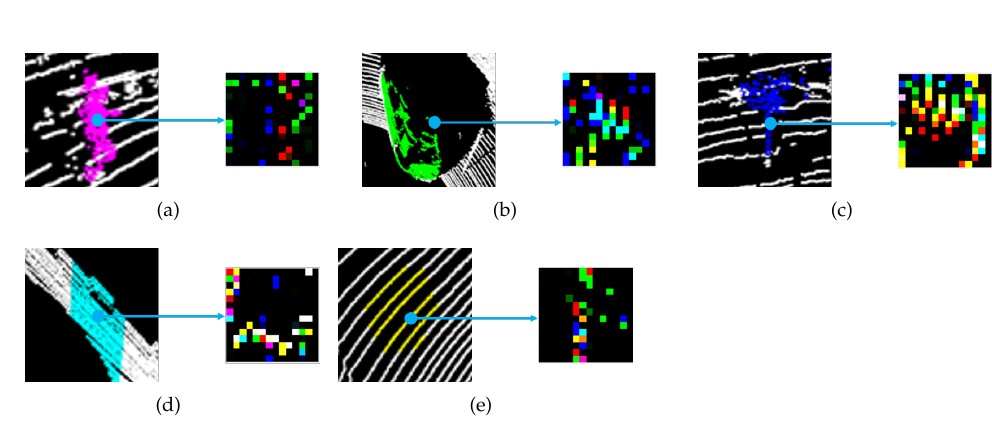
Figure 5. Example of a random sP 2 image generated for various labels: ( a ) person, ( b ) car, ( c ) tree, ( d ) wall, and ( e )